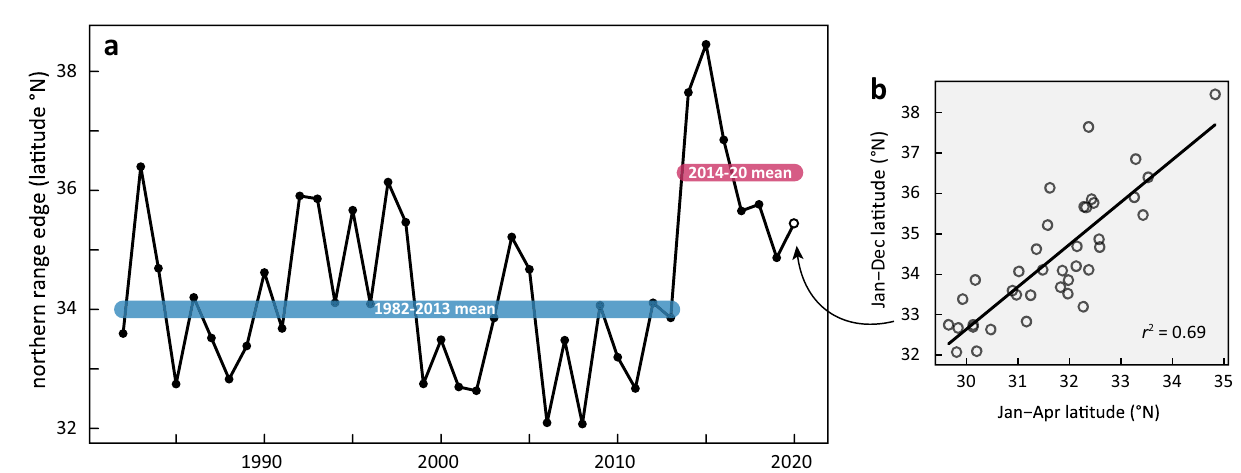
Figure 3. The cold range edge migrates poleward during the 2014–2016 North Pacific heatwave. a Annual mean position (filled circles) of the daily center of gravity for the cold edge of the binary thermal suitability model (Fig. 2b) over 1982–2020. The 1982–2013 mean position (blue line) at 34.0° N is near Point Conception (34.4° N), and consistent with historical records that juvenile white sharks largely remaining below this landmark. The 2014–2020 mean position (red line) at 36.4° N is consistent with juvenile white sharks being common in northern Monterey Bay (36.9°N) during that time. b Full-year forecast for 2020 (hollow circle in a ) was calculated from the available Jan-Apr data, and the linear relationship (r 2 = 0.69, p < 0.001) between this value and the full year using 1982–2019